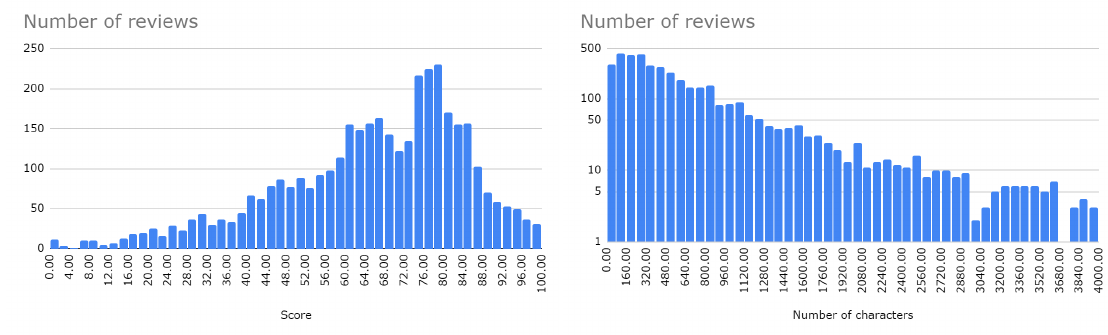
Figure 6. Detailed analysis of the